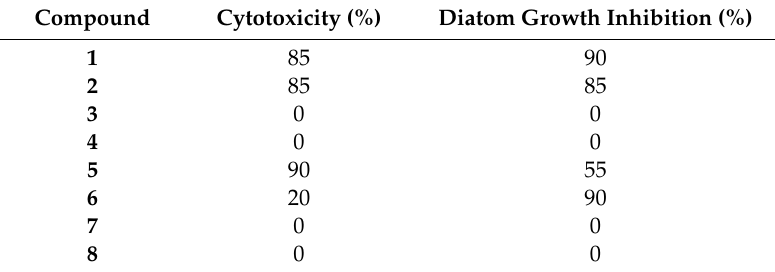
Table 2. Inhibition rates on cytotoxicity and diatom growth inhibition assays. Compound Cytotoxicity (%) Diatom Growth Inhibition (%) 1 85 90 2 85 85 3 0 0 4 0 0